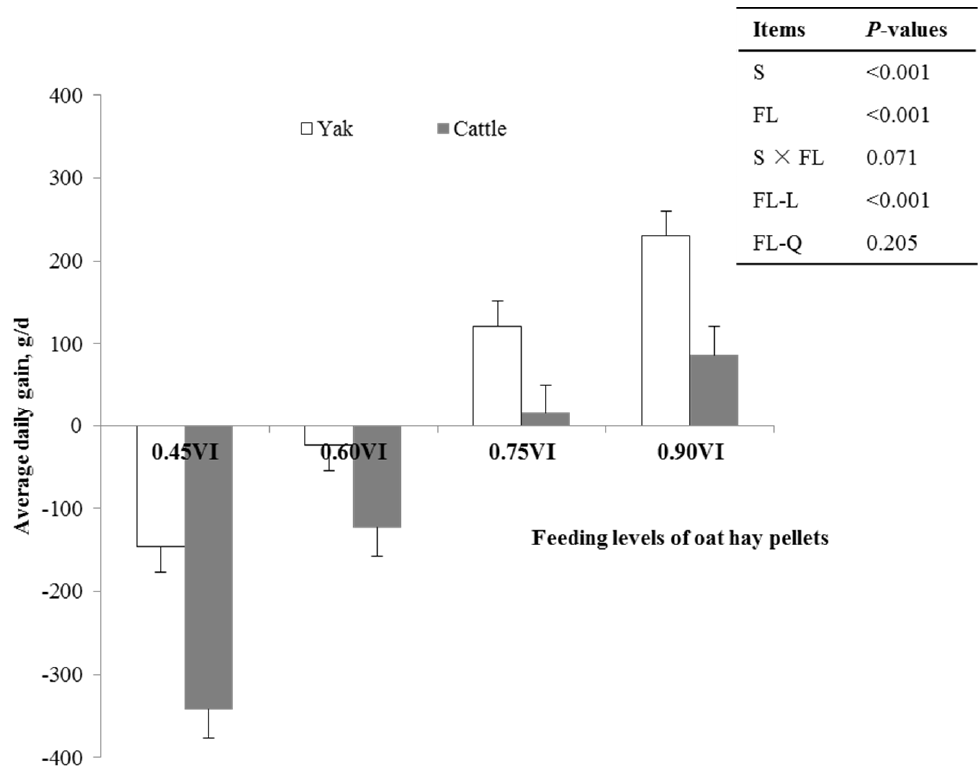
Figure 1. The average daily gain of yaks and cattle offered oat hay pellets at different feeding levels (n = 6 per treatment). S = species; FL = feeding level; FL-L = Linear effect of oat hay pellets FL; FL-Q = Quadratic effect of oat hay pellets FL. −